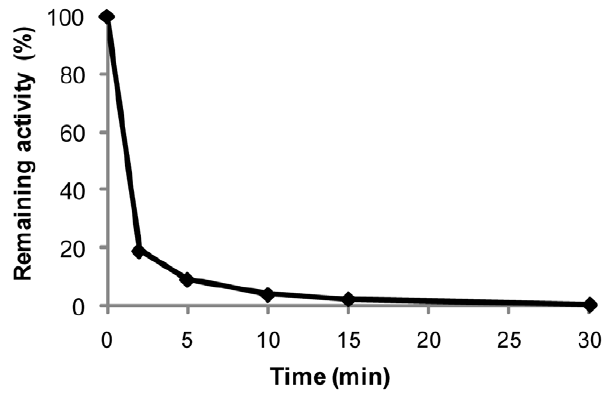
Figure 2. Thermal inactivation. Residual activity of purified Northern shrimp nuclease using the modified Kunitz assay after heating at 65 u C for indicated periods of time.